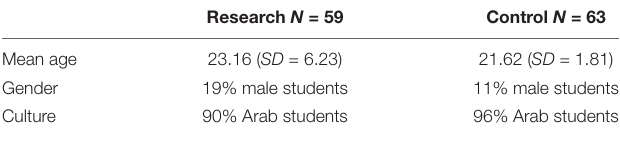
TABLE 1 | Research and control groups’ characteristics for the